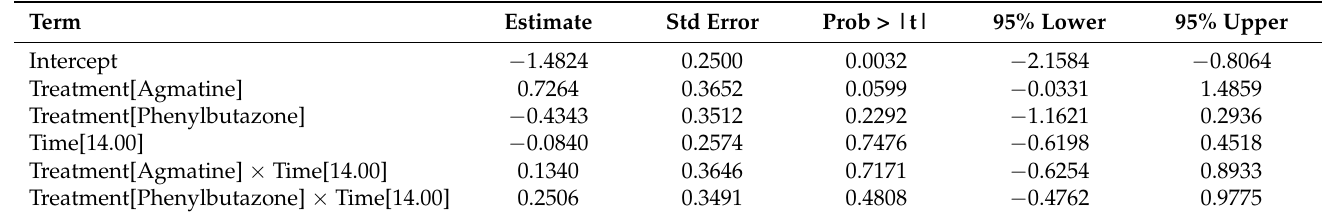
Table 5. Fixed effects parameter estimates of subjective lameness score changes. Std Error: standard error; Prob > |t|: p -value; 95% Lower: 95% confidence interval lower limit; 95% Upper: 95% confidence interval upper limit.